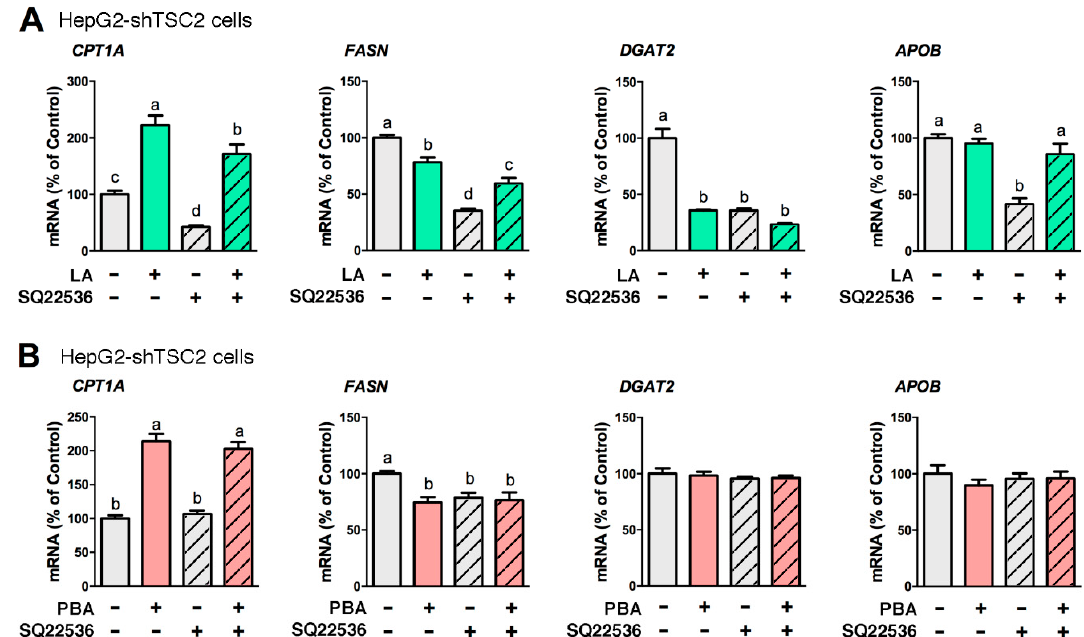
Figure 3. cAMP partakes in the mechanism of LA, but not in that of PBA. HepG2-shTSC2 cells were treated with either 200 μ M LA for 24 h ( A ) or 8 mM PBA for 6 h ( B ) along with 100 μ M SQ22536 or vehicle control. Total RNA was isolated and CPT1A , FASN , DGAT2 , APOB mRNA levels quantified by qRT-PCR. Statistical significance was determined using one-way ANOVA followed by Tukey’s multiple comparisons test. Values not sharing a common letter are significantly different, p < 0.05, n = 6.